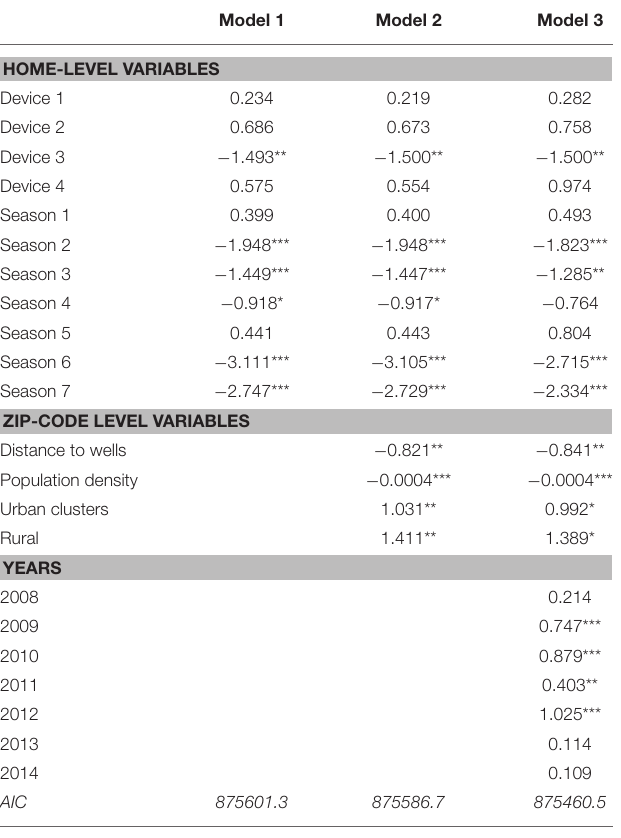
TABLE 2 | Multilevel modeling for radon concentrations from 2007 to 2014. TABLE 3 | Multilevel modeling for radon concentrations for different years.